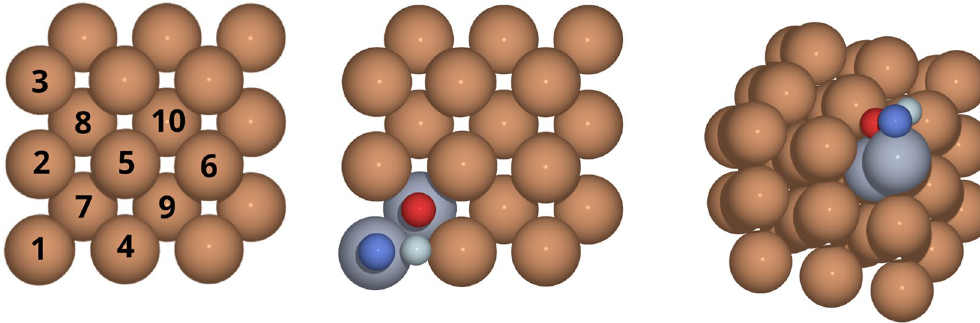
Figure 1. Left: Schematic illustration of the numbering of the Fe atoms in the two topmost atomic layers. The surface-layer atoms are numbered from 1 to 6 and the subsurface-layer atoms from 7 to 10. The three oxygen adsorption sites considered are the on-top site (‘ot’) over atom 1, the hollow site (‘ho’) over atom 7 and the bridge site (‘br’) between atoms 1 and 4. Middle: Atomic positions within the unit cell of the dilute Fe–Cr alloy with two Cr atoms (blue–grey) at sites 1 and 7. The positions of the adsorbed oxygen atom at the on-top, hollow and bridge adsorption sites are illustrated by the smaller dark blue, red and light blue spheres, respectively. Right: Same as Middle but with the viewpoint shifted so that the vertical positions of the oxygen atoms can be perceived.